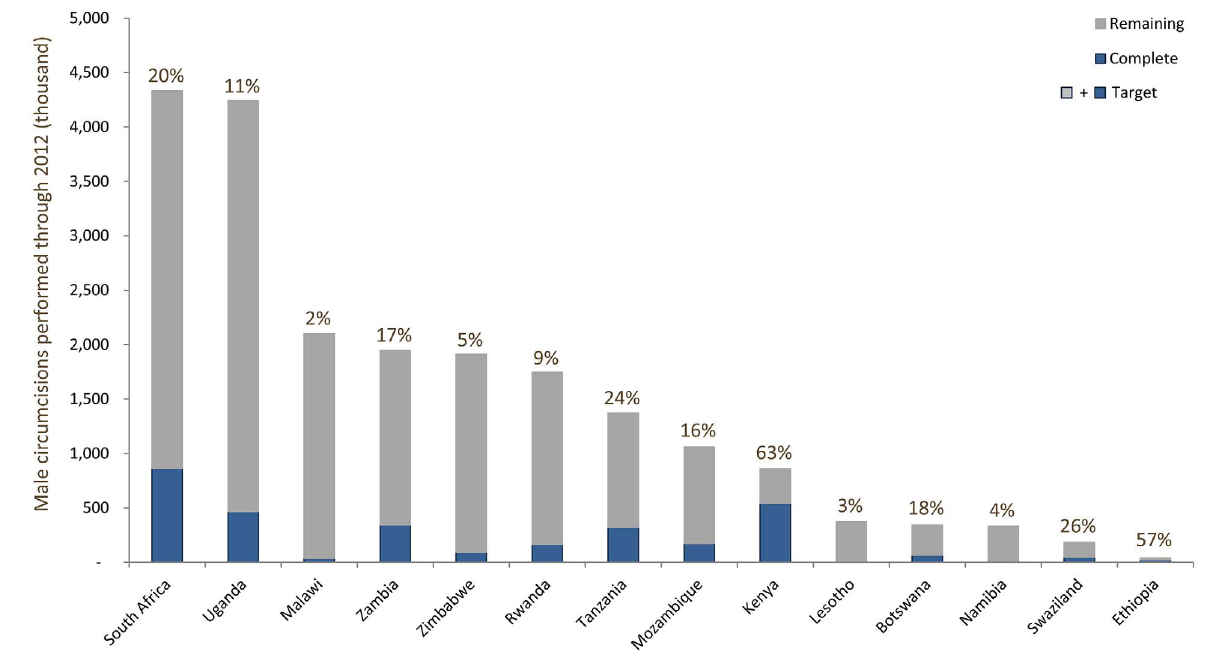
Figure 3. Scale-up of voluntary medical male circumcision program and coverage in 14 priority countries, 2008–2012. Totals reflect progress through 2012. Percentage figures represent the achieved proportion of the target of 80% coverage among males ages 15–49, but totals include circumcisions done for all age groups, regardless of the age-range target. Data obtained from WHO 2012 VMMC report [38].